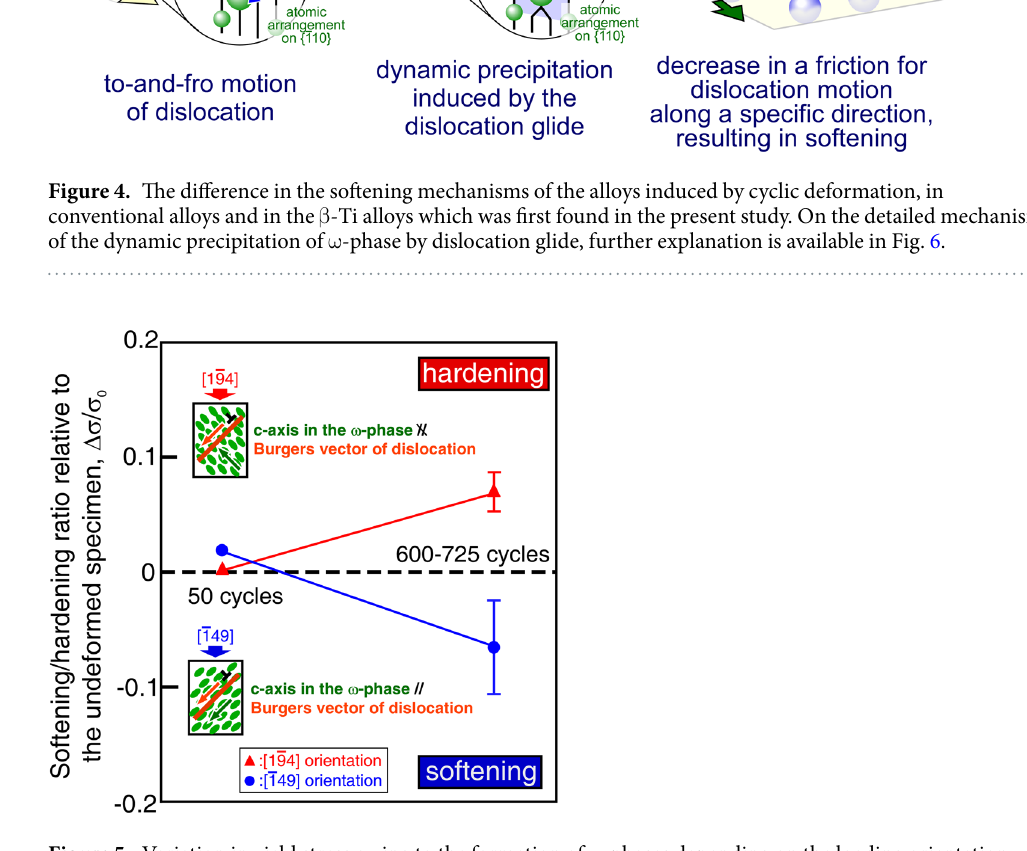
Figure 5. Variation in yield stress owing to the formation of ω -phases depending on the loading orientation. The yield stresses of specimens cut out from specimens cyclically deformed at Δε /2 = 1.1% to 50 cycles and 600–725 cycles, were examined at the [ 1 49] and [1 9 4] loading orientations. The vertical axis value indicates the softening/hardening ratio relative to the undeformed specimen, Δσ / σ 0 , where σ 0 is the yield stress of the undeformed specimen and Δσ is the difference in yield stress between the previously cyclically deformed specimen and the undeformed specimen. The positive and negative values indicate that hardening and softening are induced by the cyclic deformation,